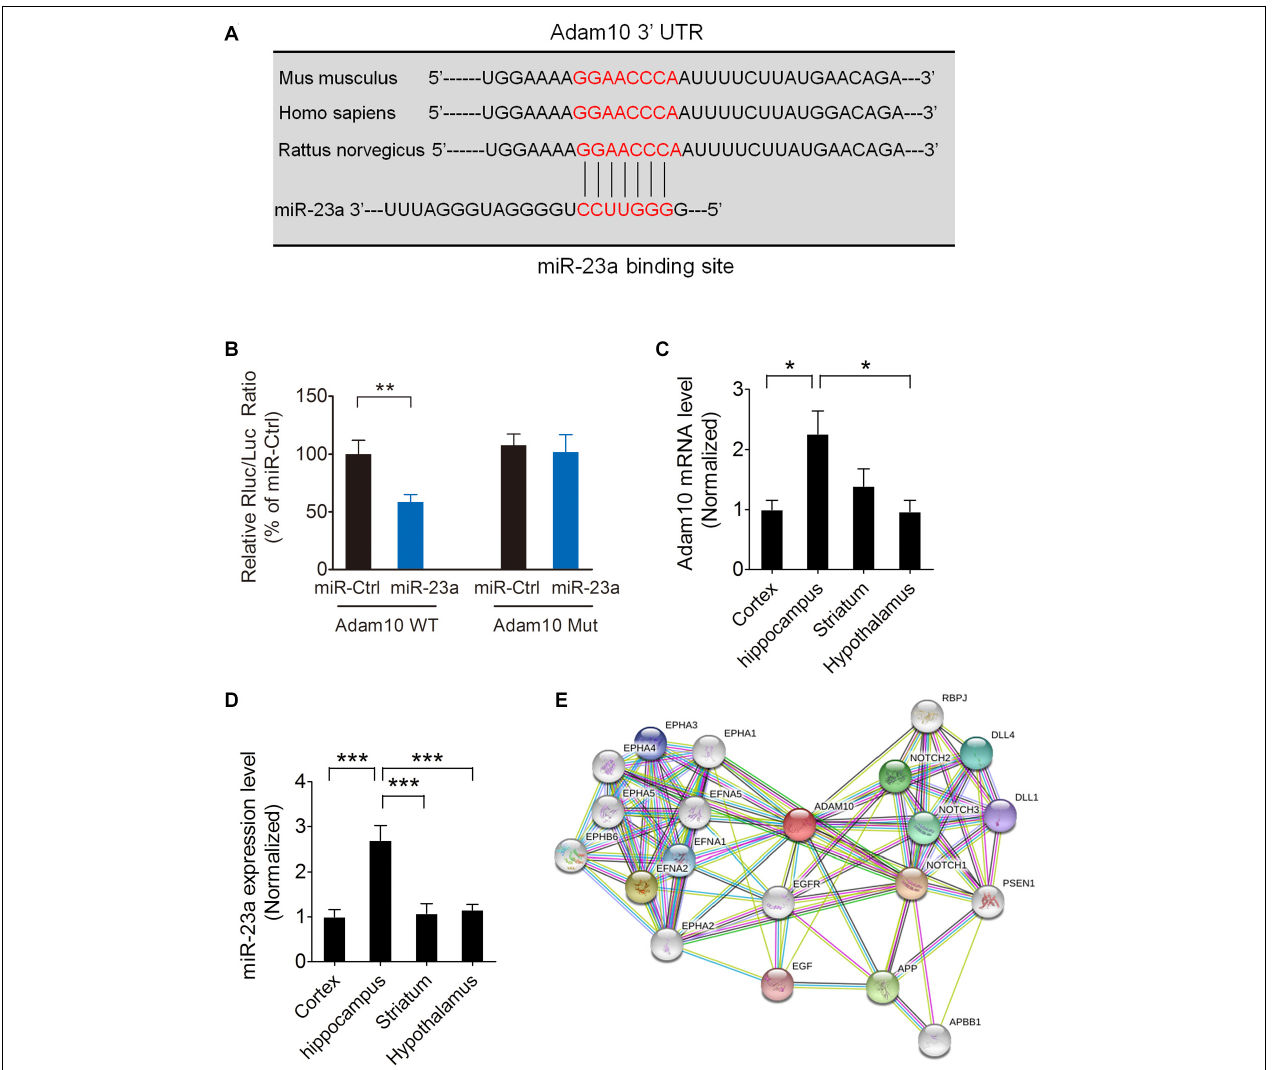
FIGURE 2 | ADAM10 is validated as a target gene of miR-23a. (A) The binding site for the miR-23a seed sequence in the ADAM10 mRNA 3 (cid:48) -UTR is highly conserved in mouse, human, and rat. (B) The relative luciferase activity of wild type or mutant ADAM10 3 (cid:48) UTR after cotransfection with a miR-23a mimic or a miR-23a mimic control in 293T cells ( p = 0.0091). (C) qRT-PCR analysis of ADAM10 expression in the cortex, hippocampus, striatum, and hypothalamus ( F 3 , 16 = 4.96, p = 0.021, Hippocampus vs. Cortex; p = 0.018, Hippocampus vs. Hypothalamus) ( n = 5). (D) qRT-PCR analysis of miR-23a expression in the cortex, hippocampus, striatum, and hypothalamus ( F 3 , 16 = 13.30, p < 0.001, Hippocampus vs. Cortex; p < 0.001, Hippocampus vs. striatum; p < 0.001, Hippocampus vs. Hypothalamus) ( n = 5). (E) ADAM10 protein interaction network analysis performed by STRING software. Values are mean ± SEM. ∗ p < 0.05, ∗∗ p < 0.01, ∗∗∗ p < 0.001, unpaired two-tailed Student’s t -test and one-way